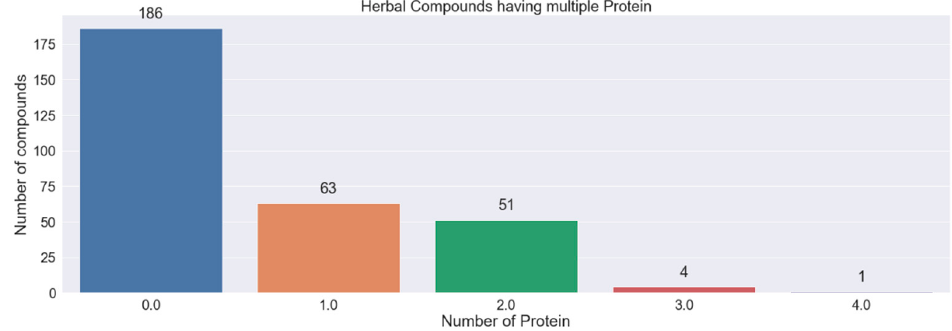
Figure 8. Details of the number of herbal compounds that interact with the protein set predicted by SAE-DNN with daylight fingerprint datasets.